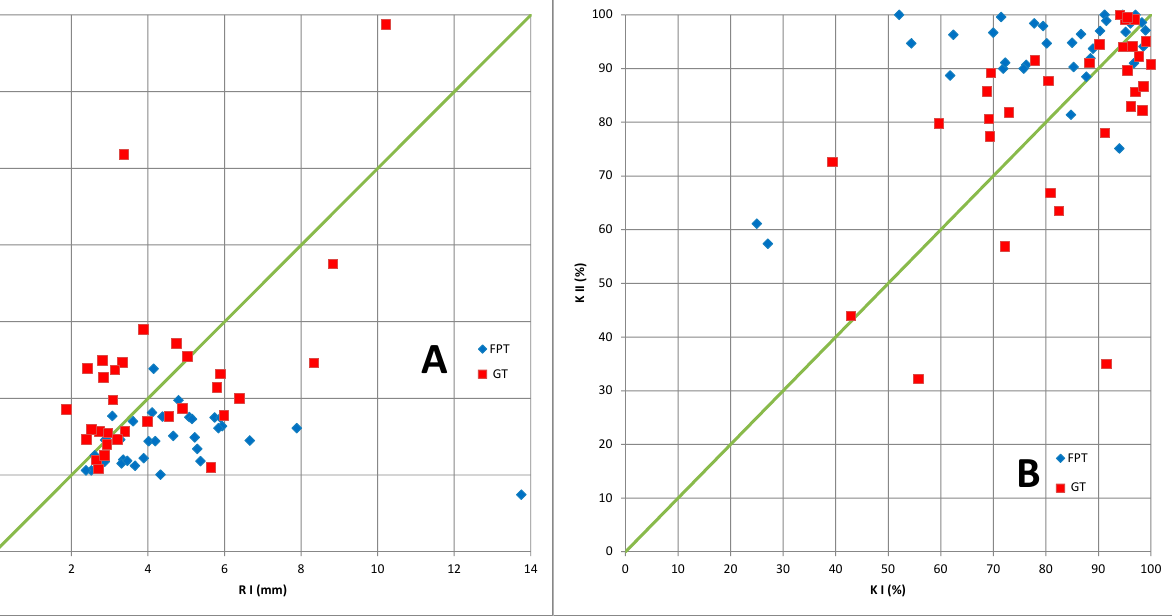
Figure 2. The scatter plot for individual patients: ( A ) radius values of sways in examination I versus II; ( B ) K% coefficient in the measurement with the feedback in examination I versus II. The horizontal axis (RI or KI) is related to examination I; and the vertical axis (RII or KII), to examination II. The areas of the plots are split with diagonal lines. In panel A, below the bisector, there are points for which RII < RI, i.e., for which the sway radius in examination II decreased compared to examination I; above the bisector, there are points with RII > RI. In panel B, above the bisector, there are points for which KII > KI, i.e., for which K% in examination II increased compared to examination I; below the bisector, there are points with KII < KI, i.e., K% coefficient in examination II was smaller than in examination I. Each point represents a patient: the blue diamonds are the FPT group, the red squares are the GT group.